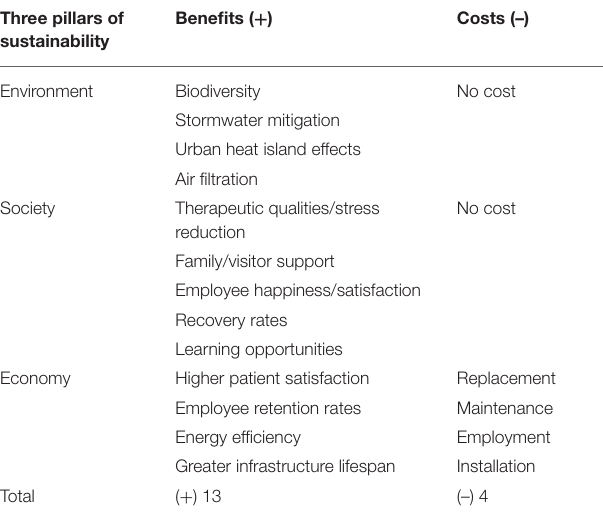
TABLE 3 | Cost-benefit comparison of the benefits green roofs offer hospitals vs. associated costs. Three pillars of